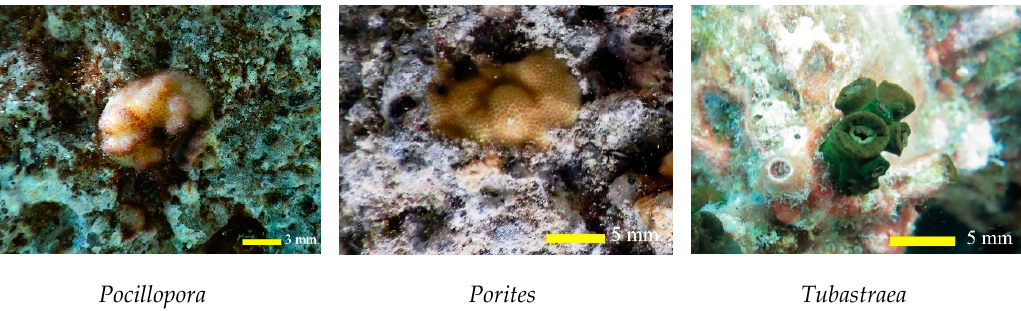
Figure 13. Dominant juvenile corals on available substrate at the study sites.